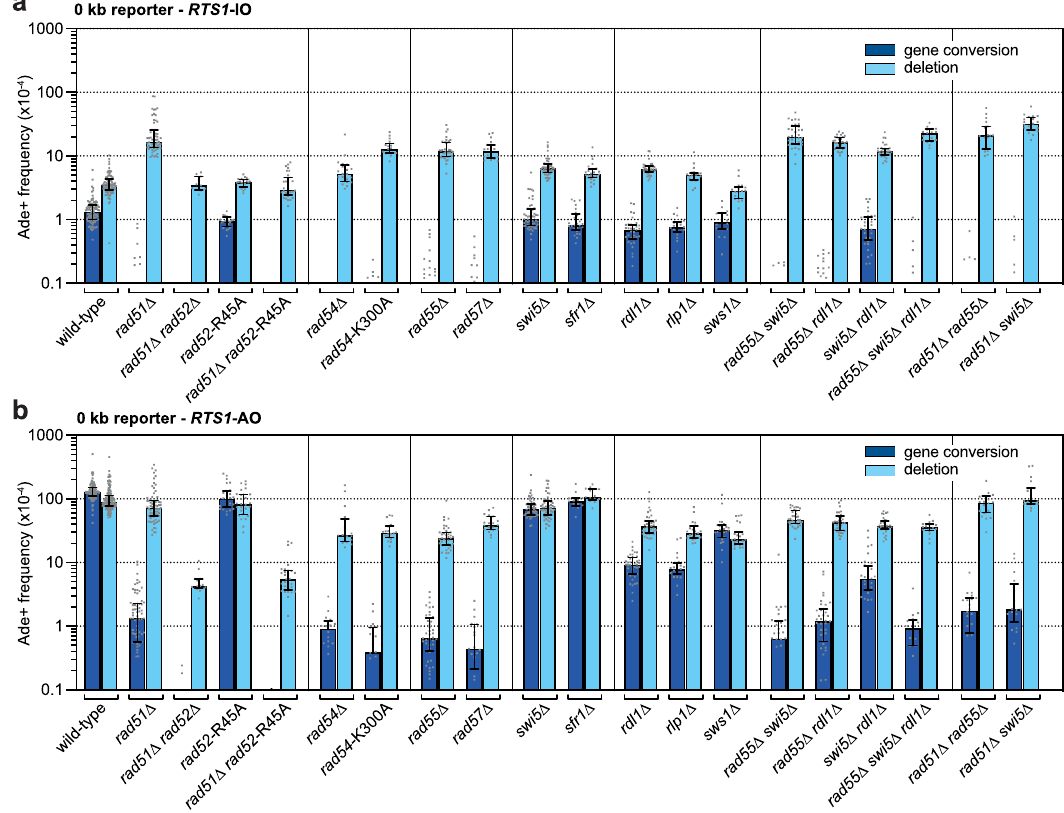
Fig. 2 | Ectopic recombination associated with RDR initiation is driven mainly by Rad51 and its auxiliary factors. a Frequency of spontaneous ( RTS1 -IO) Ade + recombinants in wild-type and mutant strains carrying the 0kb reporter. b Frequency of RTS1 -AO-induced Ade + recombinants in wild-type and mutant strains carrying the 0kb reporter. a , b Data are presented as median values±